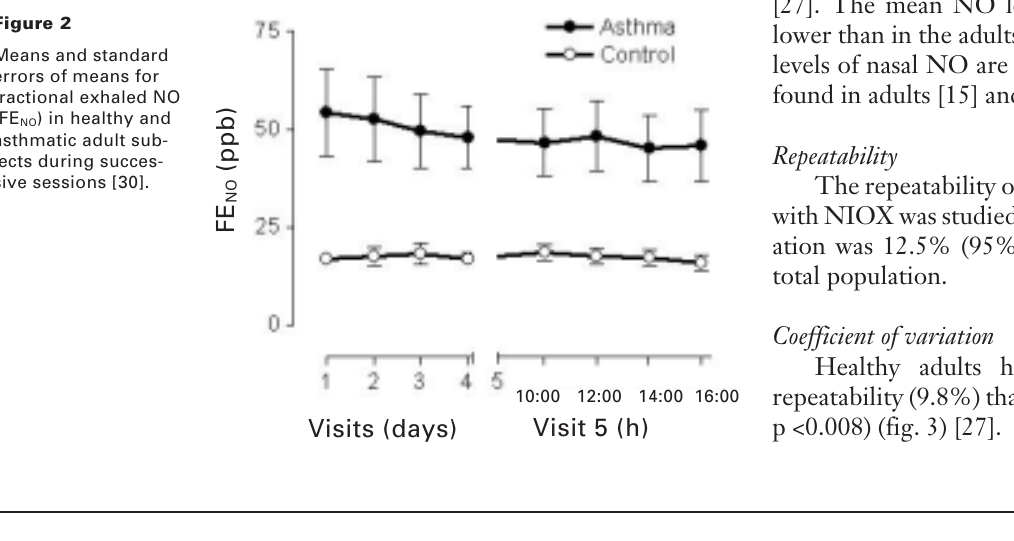
Mean distance from session mean of FE NO measured during one or two exhalations in studied population groups.